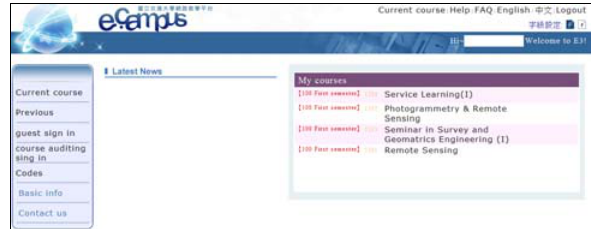
Figure 1. Main page of E-Campus.